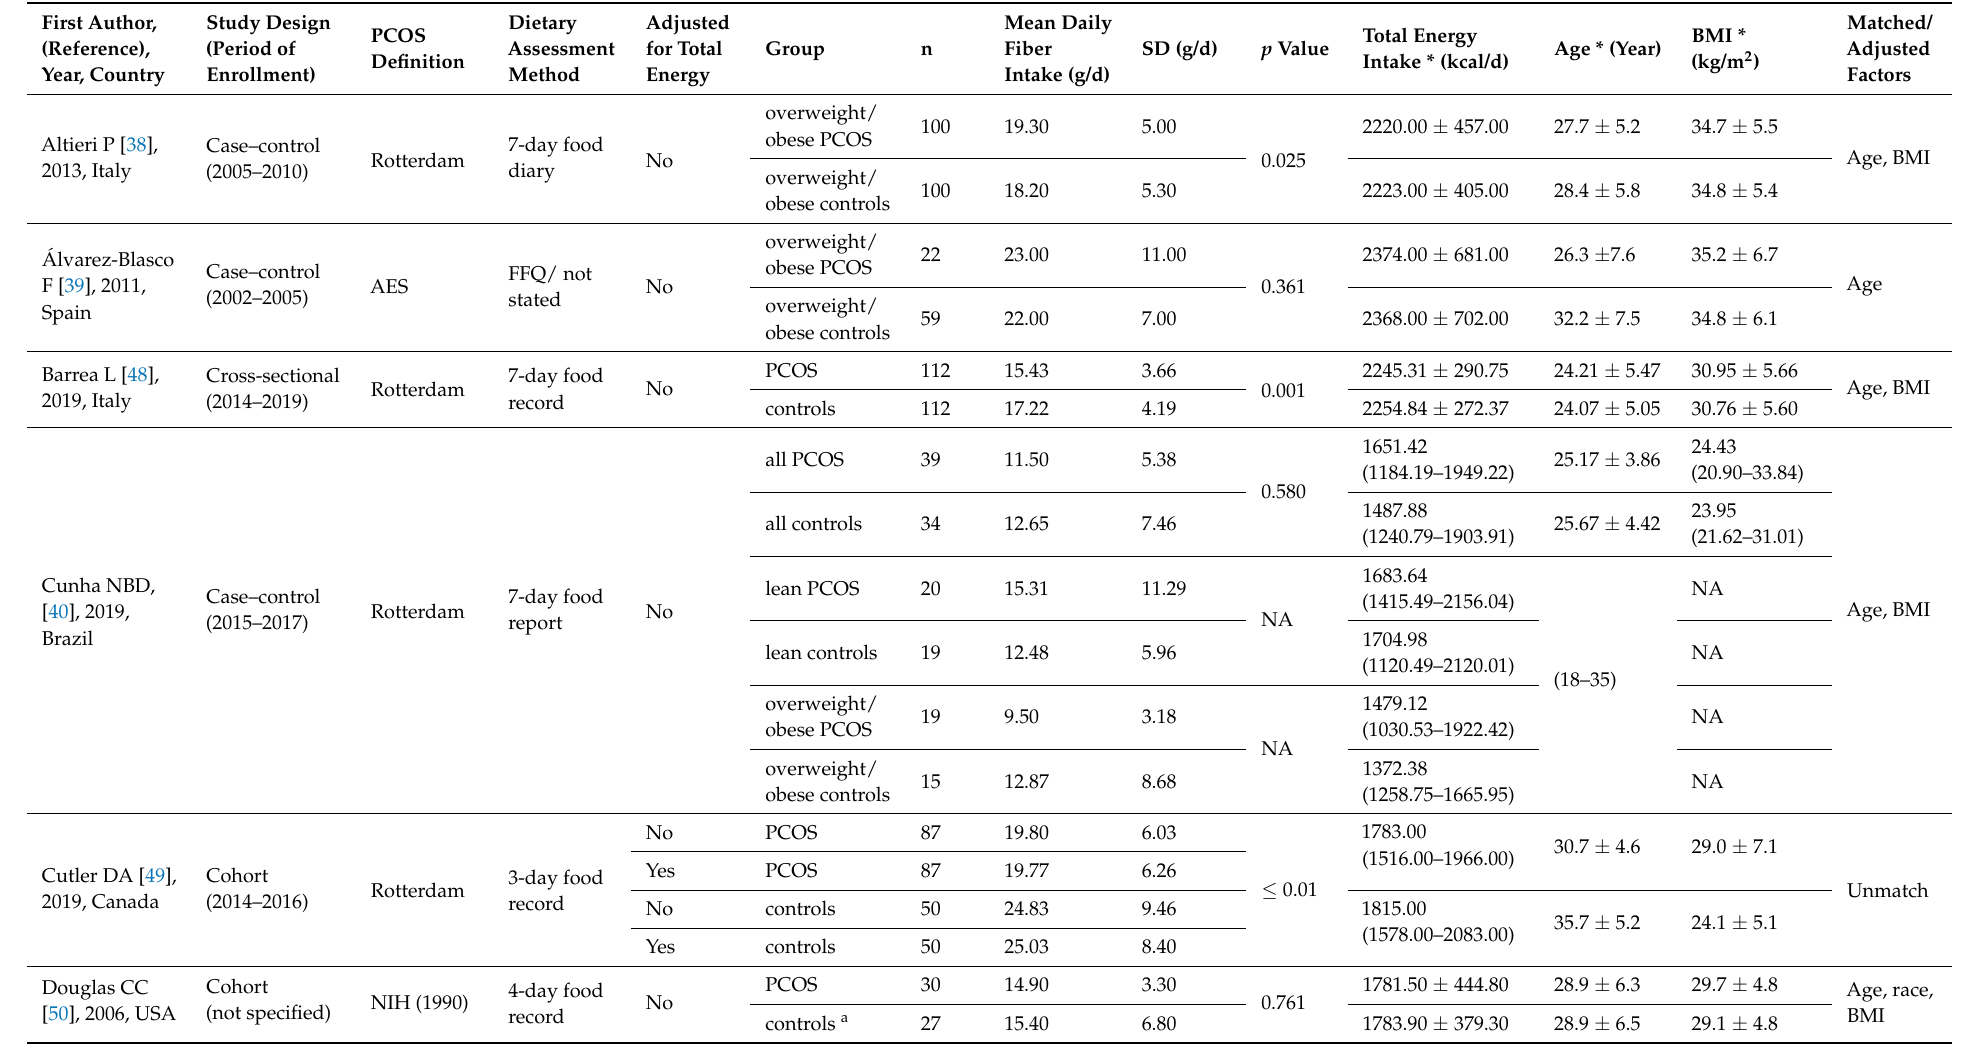
Table 1. Characteristics of the included